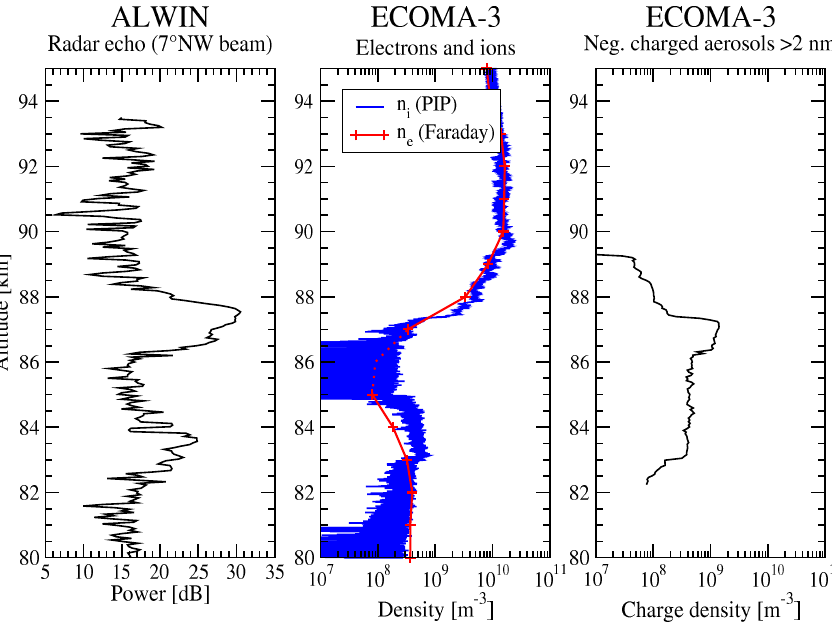
Fig. 2. Left panel: Radar echo, as measured by the ALWIN radar (50MHz) at the time of launch. The rocket was launched during conditions with PMSE and NLC. Middle panel: Measured electron and ion densities. Between 85 and 87km the electron density is below the detection limit of the Faraday instrument, approximately indicated by the dotted, red curve. Right panel: Net negative charge density carried by aerosol particles >